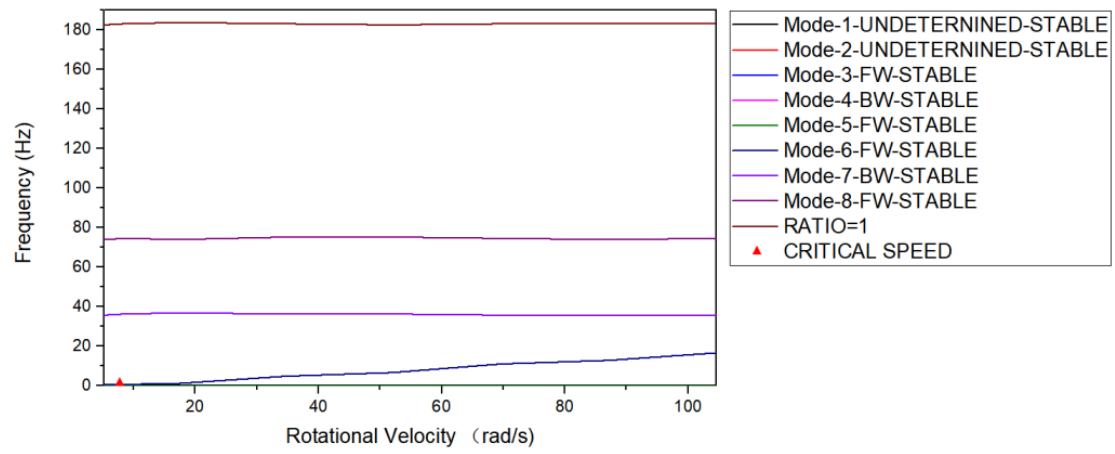
Figure 11. Campbell diagrams for M134 Gatling gun. = 8.0248 rad/s, from the Table 2, Gatling gun rpm